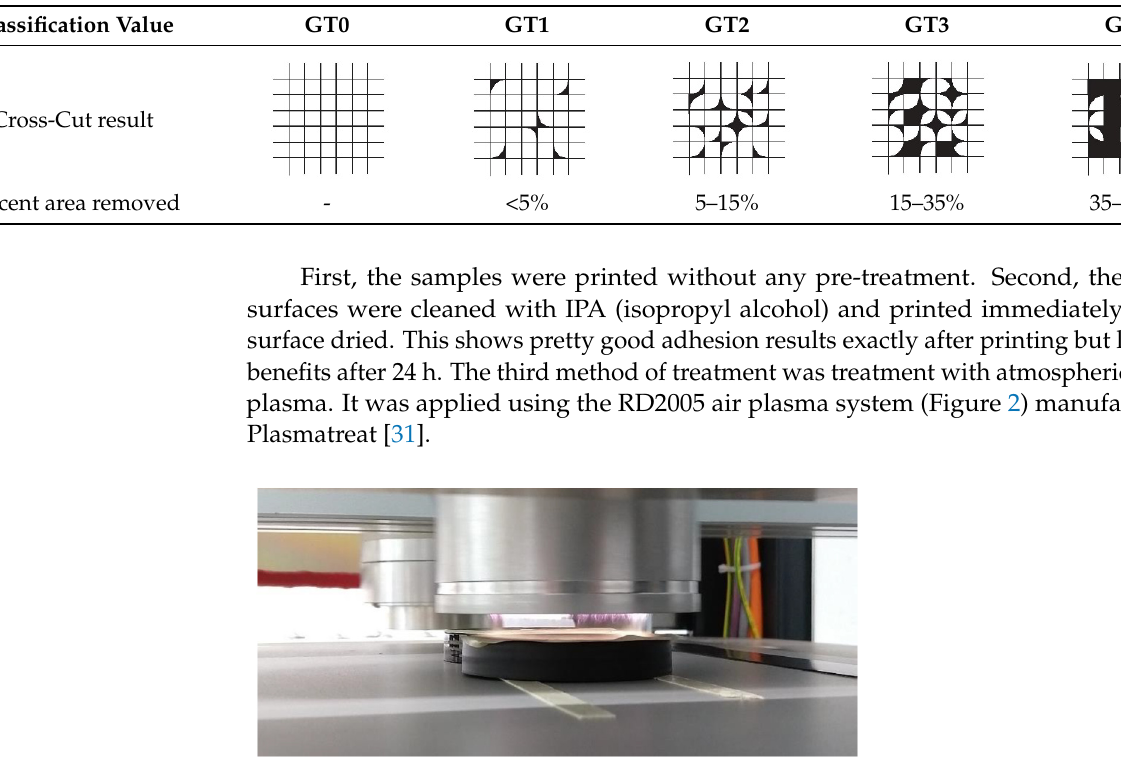
Figure 2. Activation with the RD2005 open air plasma.